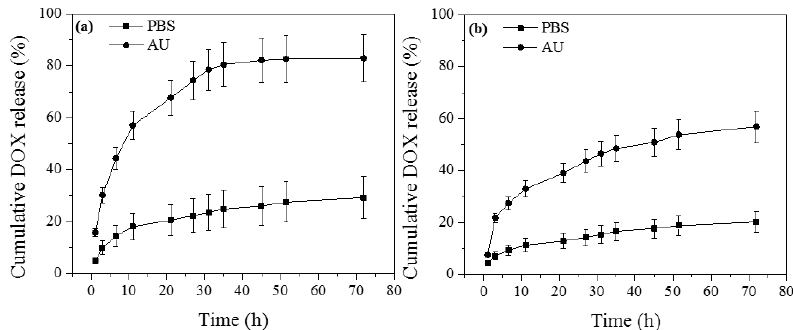
Figure 4. Cumulative DOX release from: ( a ) DOX-loaded PCL1- b -PManEA@ConA micelles; and ( b ) DOX-loaded PCL2- b -PManEA@ConA micelles in phosphate buffered saline (PBS) and artificial urine (AU).